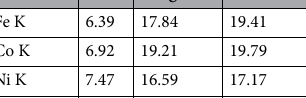
Table 1. STEM-EDS of HEA thin film prepared by pulse electrodeposition (data corresponds to Fig. 1b).